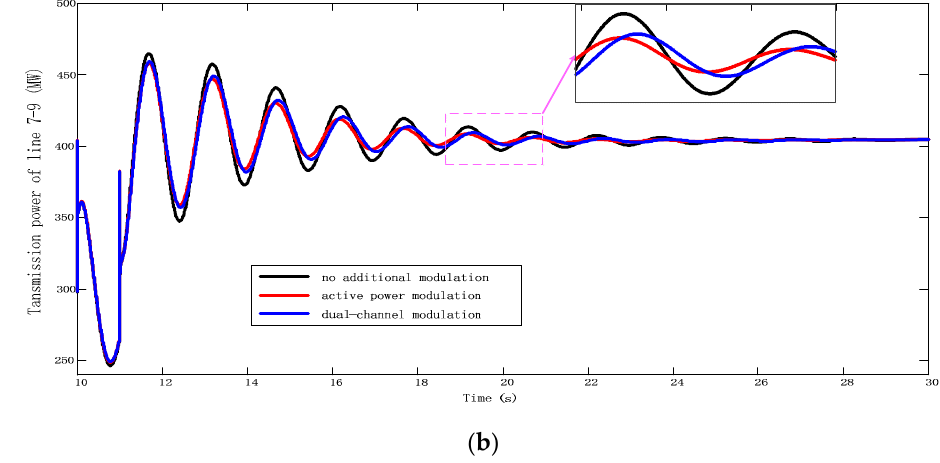
Figure 8. ( a ) Transmission power of Line 7–9 at Case A; ( b ) Transmission power of Line 7–9 at Case B.